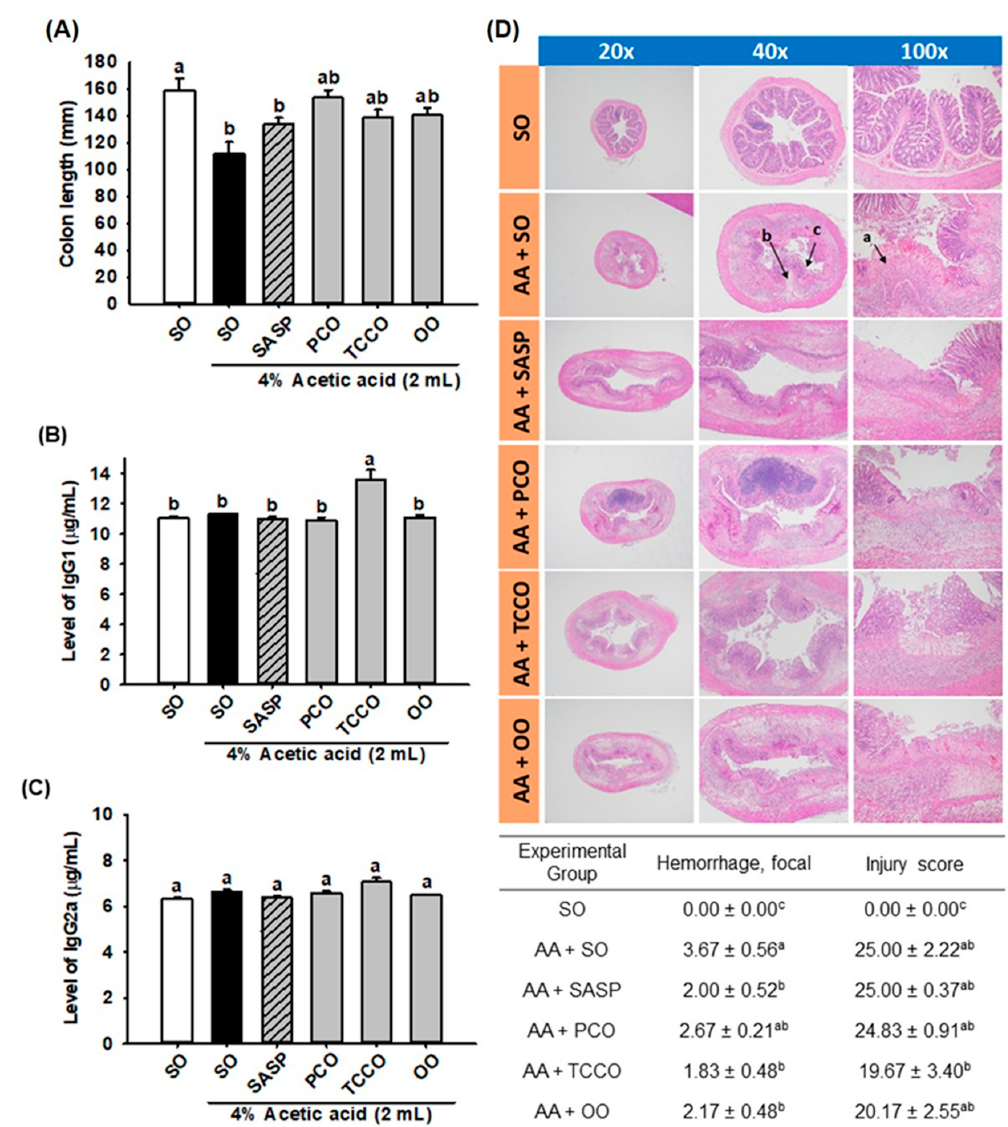
Figure 3. Effects of SO, PCO, TCCO, and OO on ( A ) colon length, ( B ) IgG1 levels, ( C ) IgG2a levels, and ( D ) hematoxylin and eosin (H&E) staining in Sprague–Dawley rats with AA-induced colitis. The rats received oral administration of SO, PCO, TCCO, or OO for 3 weeks. Then, AA was administered intrarectally for the induction of colitis (except in the normal control group). SASP was used as a positive control after inducing colitis by using AA. The rats were sacrificed on day 3, and their colon tissues were excised. The results are expressed as the mean ± SEM ( n = 6). Values assigned different letters are significantly different at p < 0.05, which was determined using Duncan’s multiple range test. SO, 2 mL/kg body weight (BW) of soybean oil; AA, 2 mL of 4% of AA; SASP, 500 mg/kg BW of sulfasalazine; PCO, 2 mL/kg BW of C. oleifera oil; TCCO, 2 mL/kg BW of C. brevistyla oil; and OO, 2 mL/kg BW of olive oil. a, ulceration; b, edema; and c, lost crypts.